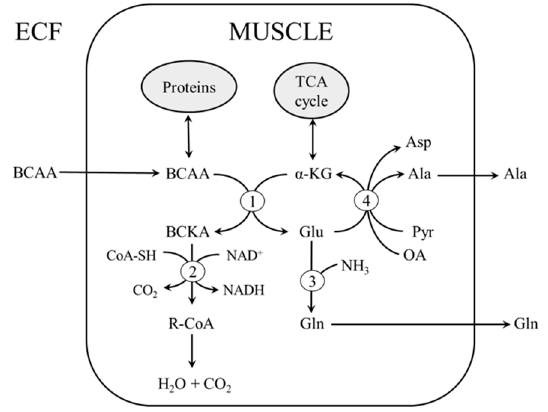
Figure 3. Transamination of the BCAA to BCKA can be affected by supply of the BCAA, activity of TCA cycle, decarboxylation of BCKA, and glutamate conversion to glutamine or α -KG. 1, Branched-chain amino acid aminotransferase; 2, branched-chain α -keto acid dehydrogenase; 3, glutamine synthetase; 4, alanine aminotransferase and aspartate aminotransferase. ECF, extracellular fluid; R-CoA, acyl-CoA.